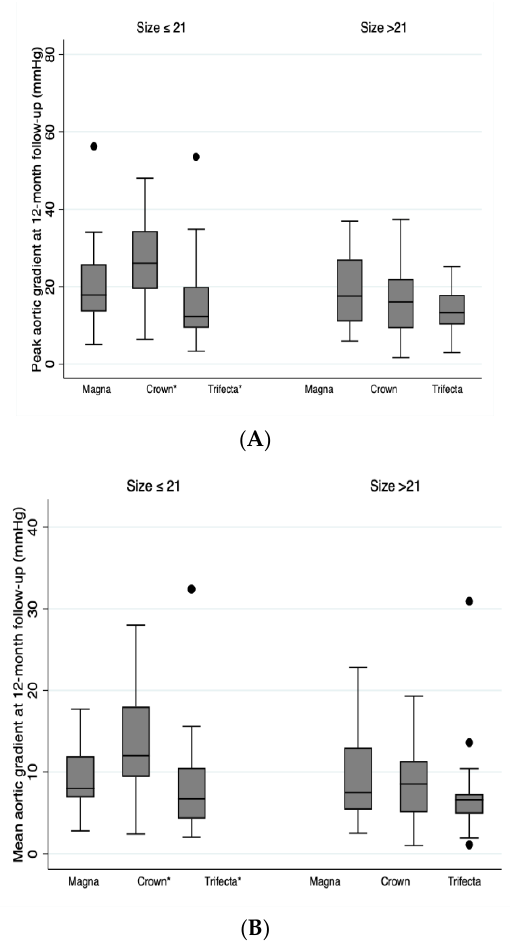
Figure 3. Box Plot for peak aortic gradient ( A ) and the mean aortic gradient ( B ) at 12 months after the surgery by size and type of prosthesis. * p = 0.001.